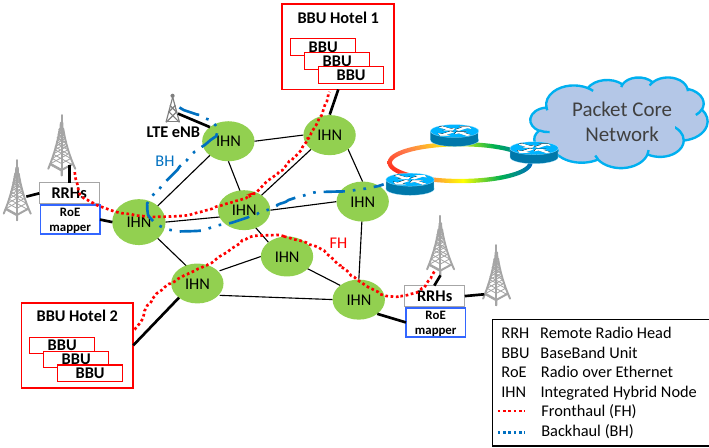
Figure 1. Converged fronthaul/backhaul